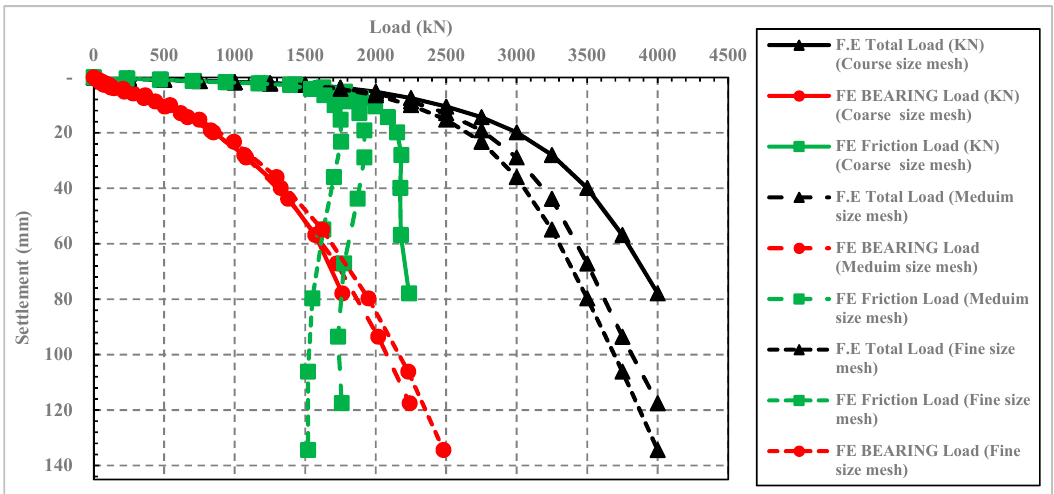
Figure 4. Comparison between pile settlement, total, bearing, and friction resistances results of the three finite element models with different levels of mesh refinement.